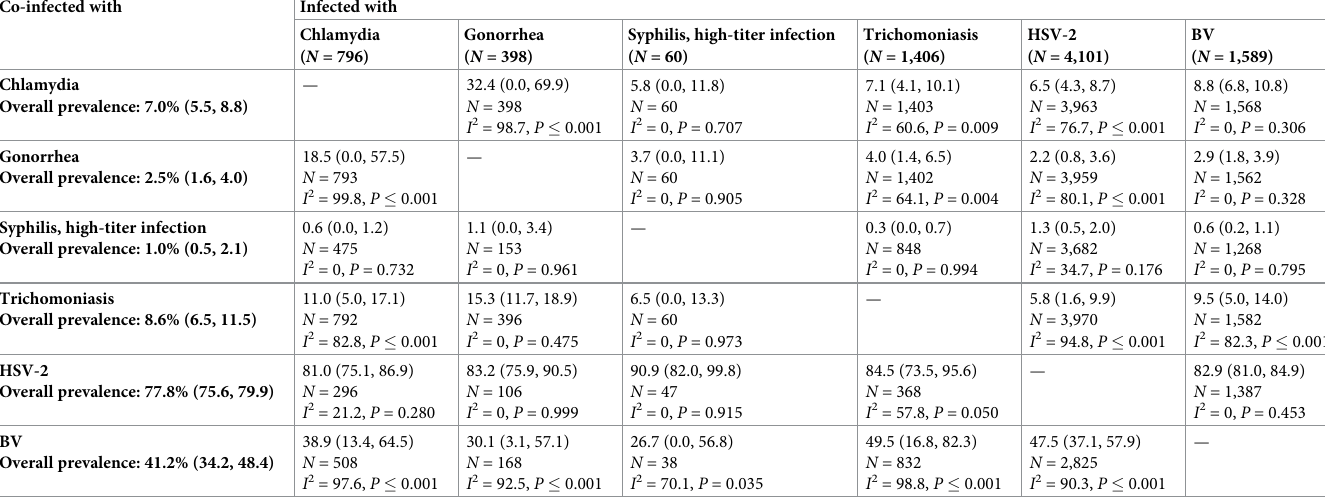
Data are presented as percent (95% CI) infected with the column infection who are co-infected with the row infection. N is the number of participants who were infected with the column infection and were also tested for the row infection; includes data from studies where at least 80% of all participants or at least 80% of a randomly selected sample of enrolled participants were tested for both